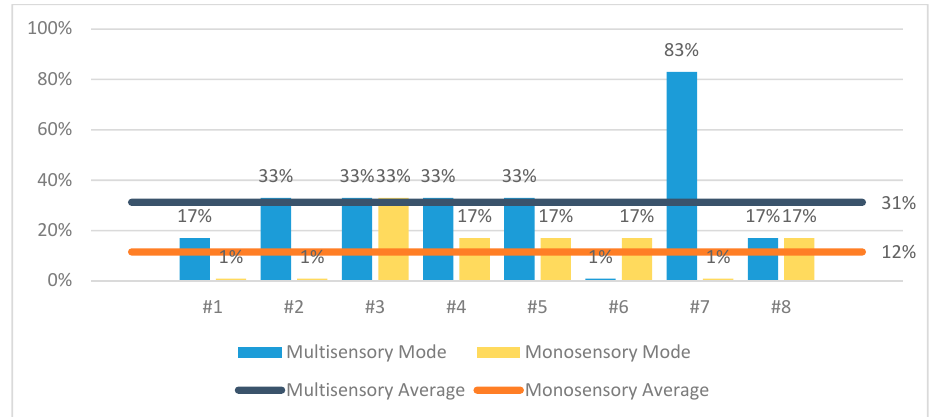
Figure 7. Subjective stress reduction per participant of the CaLmi evaluation.